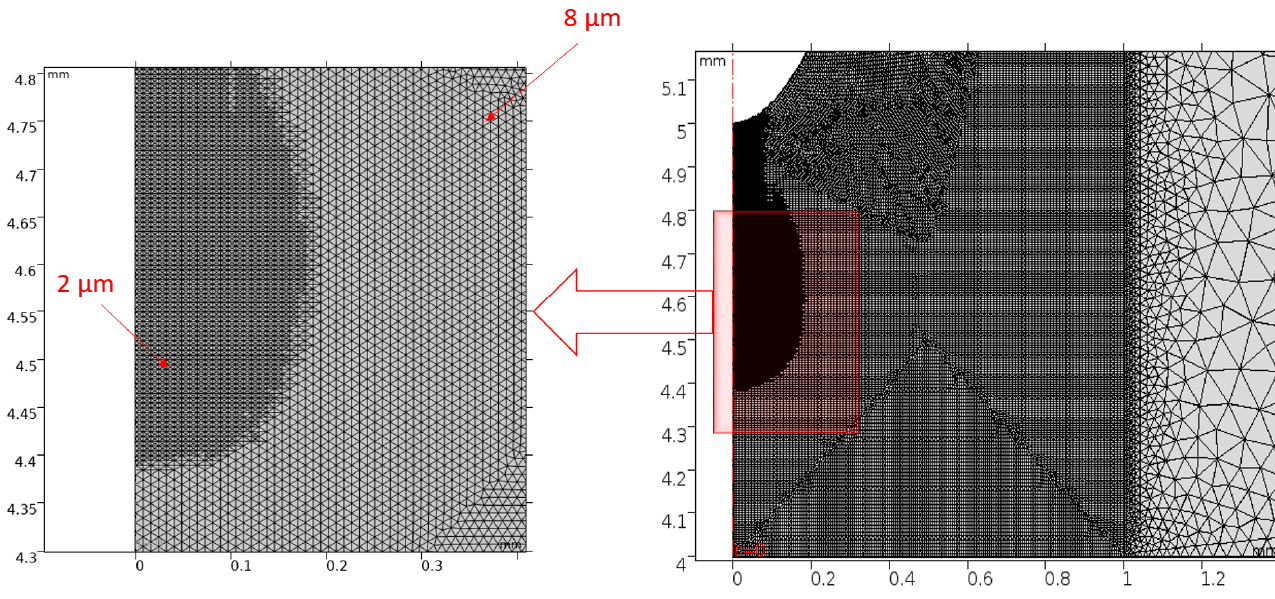
Figure 4. Mesh Sizes and Refinement.